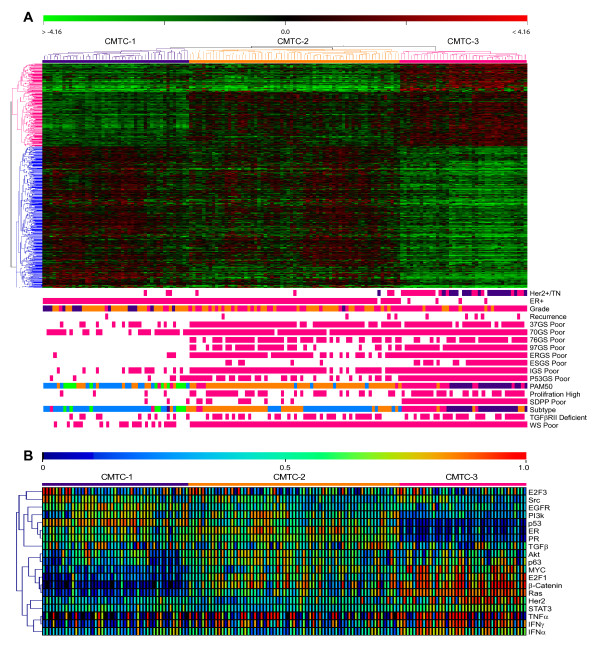
CMTC gene expression pattern, prognostic framework, and oncogenic pathway activity. (A) The 803-gene signature (represented by 828 oligonucleotide probes) was used to classify the gene expression pattern in the 149 breast cancers in the training cohort into the three main clusters of CMTC. Tumors in CMTC-3 were mostly Her2+/TN as well as CMTC-1 and CMTC-2 non-Her2+/TN. The bottom multicolor bars indicating Her2+/TN are as follows: Her2+, deep pink; TN, dark blue. The multicolor bars indicating grade are as follows: grade 1, dark blue; grade 2, dark orange; and grade 3, deep pink. The multicolor bars indicating subtype and PAM50 are as follows: normal-like, lime; luminal A, blue; luminal B, dark orange; basal-like, dark blue; and Her2+, deep pink. CMTC = ClinicoMolecular Triad Classification; Her2 = human epidermal growth factor receptor 2; TN = triple-negative; ER2+ = estrogen receptor-positive; TGFβRII = transforming growth factor β receptor type II. (B) The probabilities of pathway activation of 19 published oncogenic pathway signatures in the 149 breast cancers in the training cohort. Blue indicates low pathway activity, and red indicates high activity. EGFR = epidermal growth factor receptor; PAM50 = 50-gene prediction analysis of microarray; PI3K = phosphatidylinositol 3-kinase; PR = progesterone receptor; STAT3 = signal transducer and activator of transcription 3.